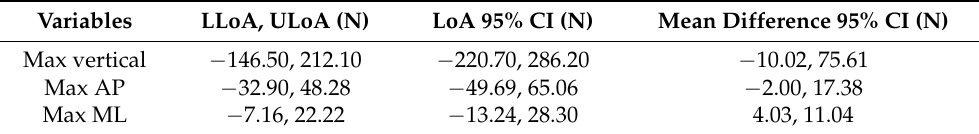
Figure 5. Bland–Altman plots of the estimated GRF vs. measured GRF (max vertical, AP, and ML). The straight line and the dotted line represent the bias and SD limits. Table 3. Results of Bland–Altman analysis on test